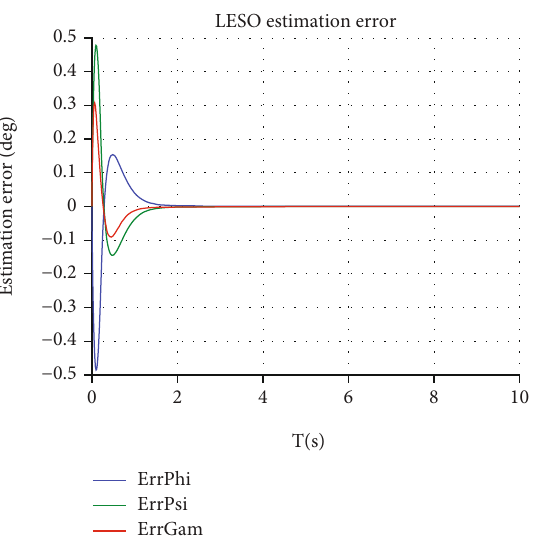
Figure 5: LESO attitude angle estimation error.